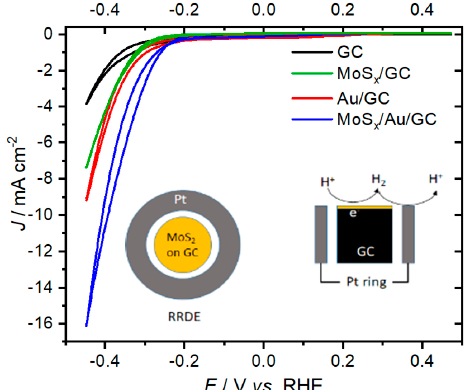
Figure 9. RRDE responses (rotation speed: 4900 rpm) for bare GC, Au/GC, 0.1 mM MoS x /GC, and 0.1 mM MoS x /Au/GC electrodes. The inset shows the schematic diagram of GC-Pt RRDE with deposition of Au and/or MoS x /Au on GC and side view depicting reduction-oxidation reactions on the respective electrodes. Scan rate: 50 mV s − 1 ; electrolyte: 0.5 M H 2 SO 4 degassed using N 2 .